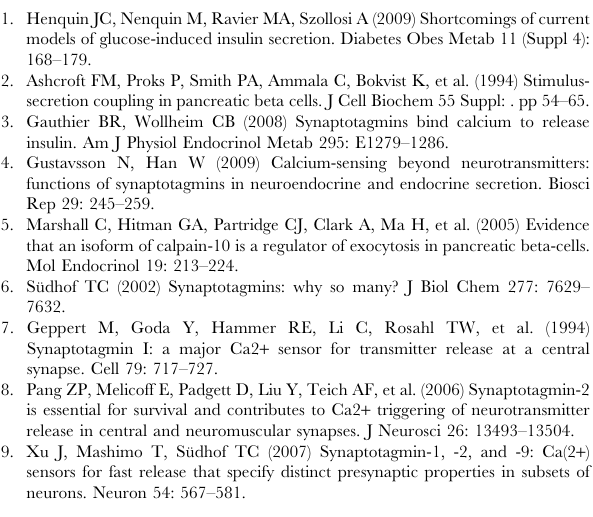
Figure S1 P-S9X mice exhibited similar body weight and body composition as their control mice. (A) Body weight development of p-S9X and control mice. Body weights were measured on these two groups of mice between the age of 4 and 15 weeks. (B) Body fat and lean content in p-S9X and control mice were measured when the mice were 14–15 weeks old. Data are presented as means 6 SEM. N= 9 for control (white bar) and 4 for p-S9X (grey bar). (EPS) Figure S2 Normal calcium response in p-S9X mouse islets. Representative calcium responses induced by a rise in glucose concentration from 3 to 20 mM in control (red trace) and p-S9X (black trace) mouse islets (N = 23 and 26, respectively). P- S9X and control islets showed similar calcium response pattern with regard to timing of response (lag time) and amplitude of calcium rise (see RESULTS section for mean values and SEM). Figure S3 Comparison of insulin secretion in control, synaptotagmin-7 KO and synaptotagmin-7/-9 DKO mouse islets. Insulin secretion in response to 20 mM glucose was measured in batches of 5 similar-sized islets during the first 15 minutes ( A , first phase) and the second 15 minutes ( B , second phase). N= 18, 39 and 28 for control (Ctrl., white bar), synaptotagmin-7 KO (Syt7 2 / 2 , grey bar) and synaptotagmin-7/ -9 DKO (DKO, black bar), respectively. Data are presented as means 6 SEM. Statistics is indicated on the graph. NS: not significant.